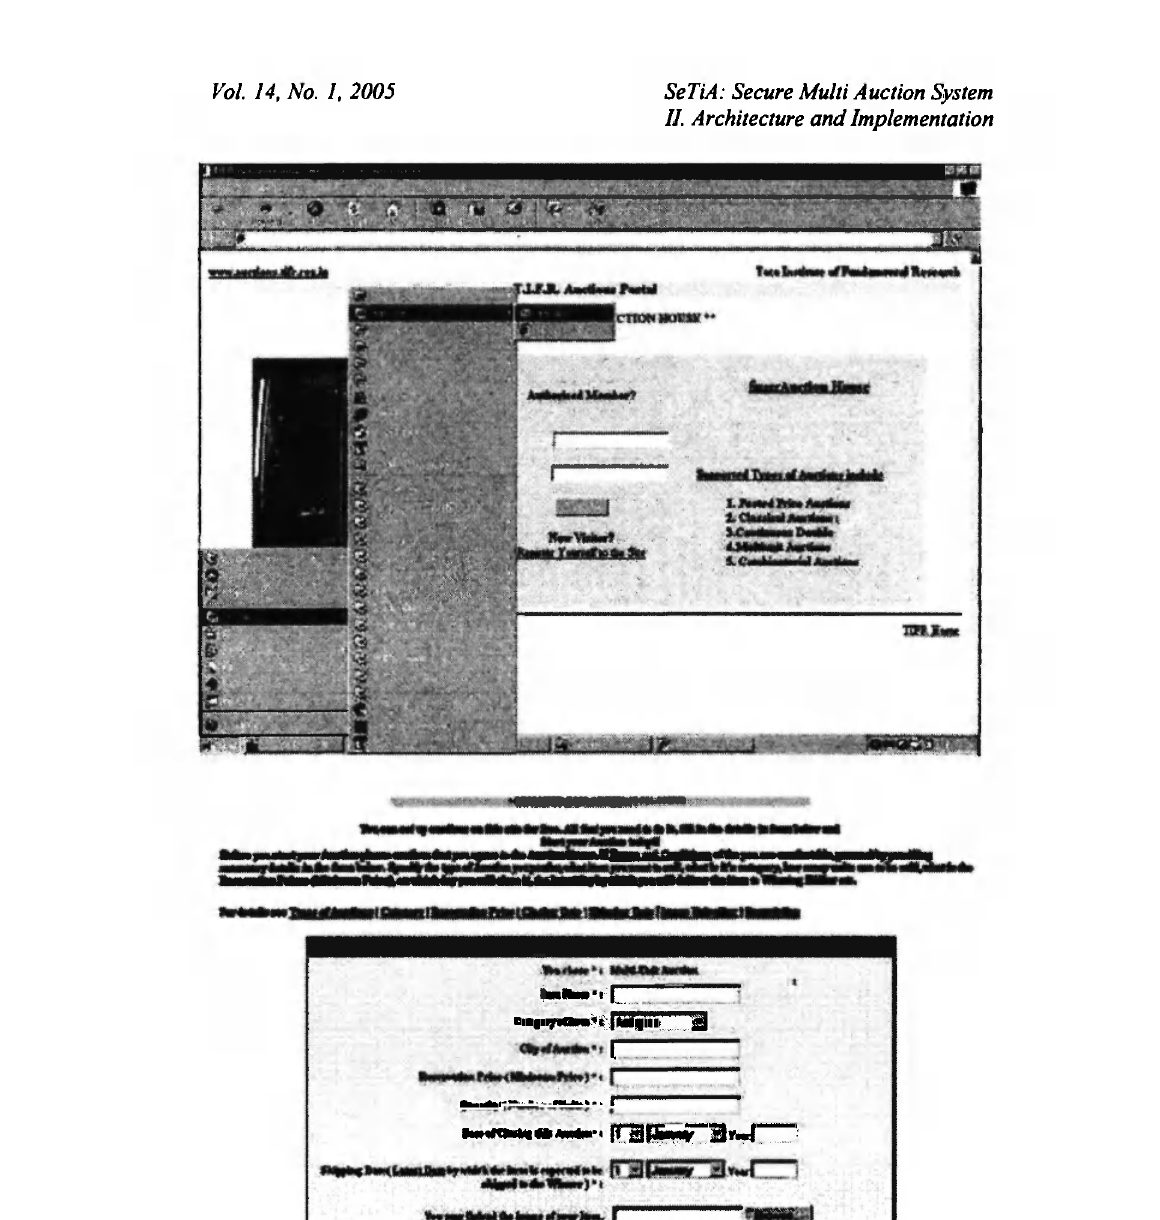
Fig. 2: SeTiA Architecture (upper) Fig. 3: SeTiA Welcome Page